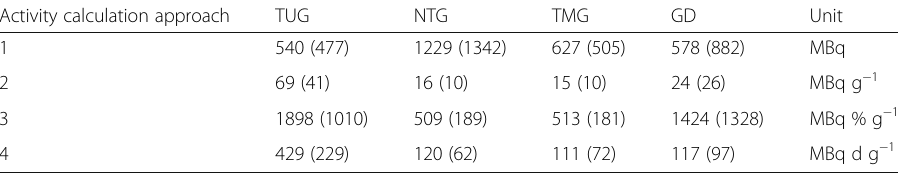
Table 2 Optimized activities ( A opt,i ) determined in approaches 1 – 4 to calculation Activity calculation approach